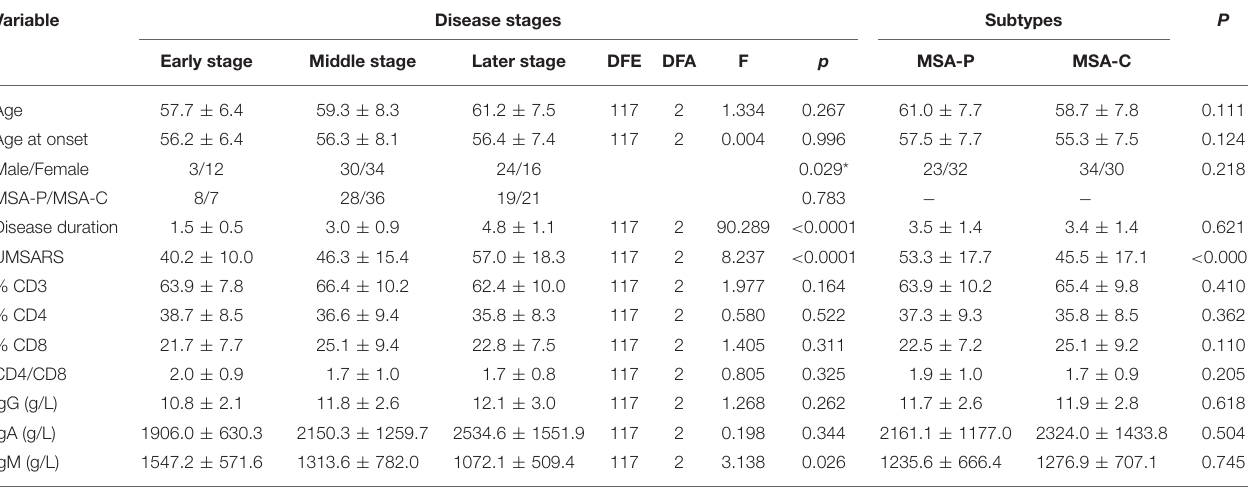
TABLE 2 | Demographic characteristics and PIA variables of different stages and subtypes in dead MSA patients. Variable